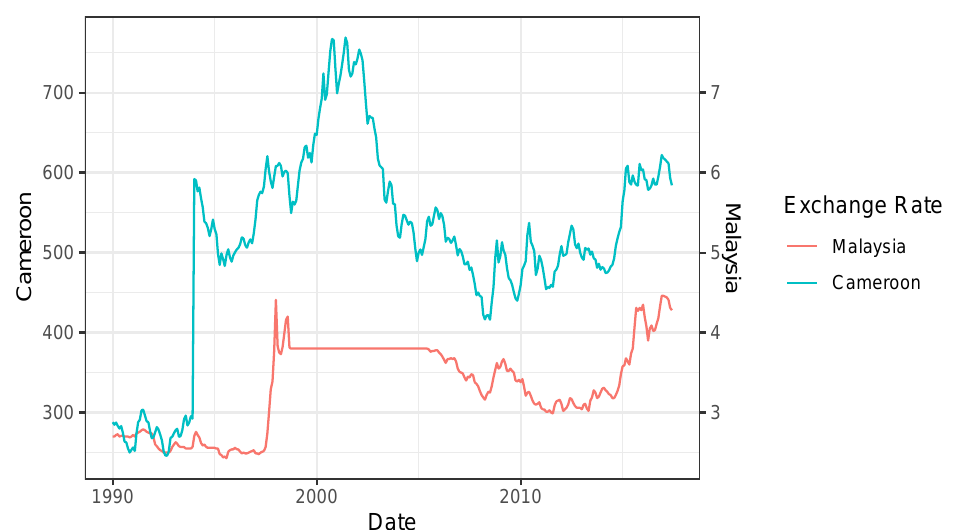
Figure 2. Nominal Exchange Rate, USD per Malaysian ringgit and USD per Central African CFA franc of Cameroon. The data covers a set of monthly average exchange rates ranging from January 1990 to November 2019. Exchange rate data were collected from the International Financial Statistics (IFS) curated by the International Monetary Fund (IMF).